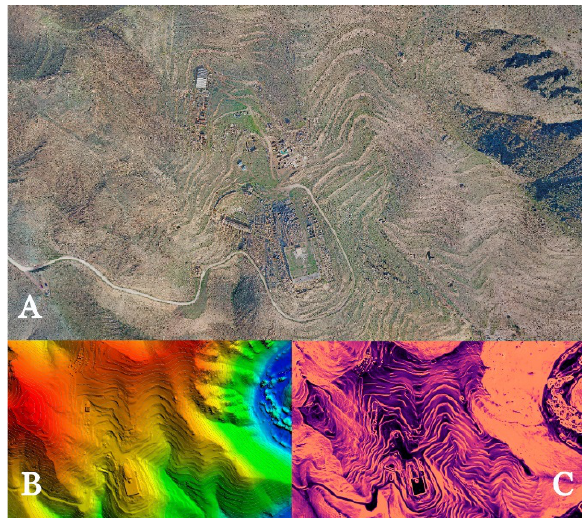
Figure 5. Photogrammetric survey made with RPAS/drone over a Roman archaeological site (40 hectares).